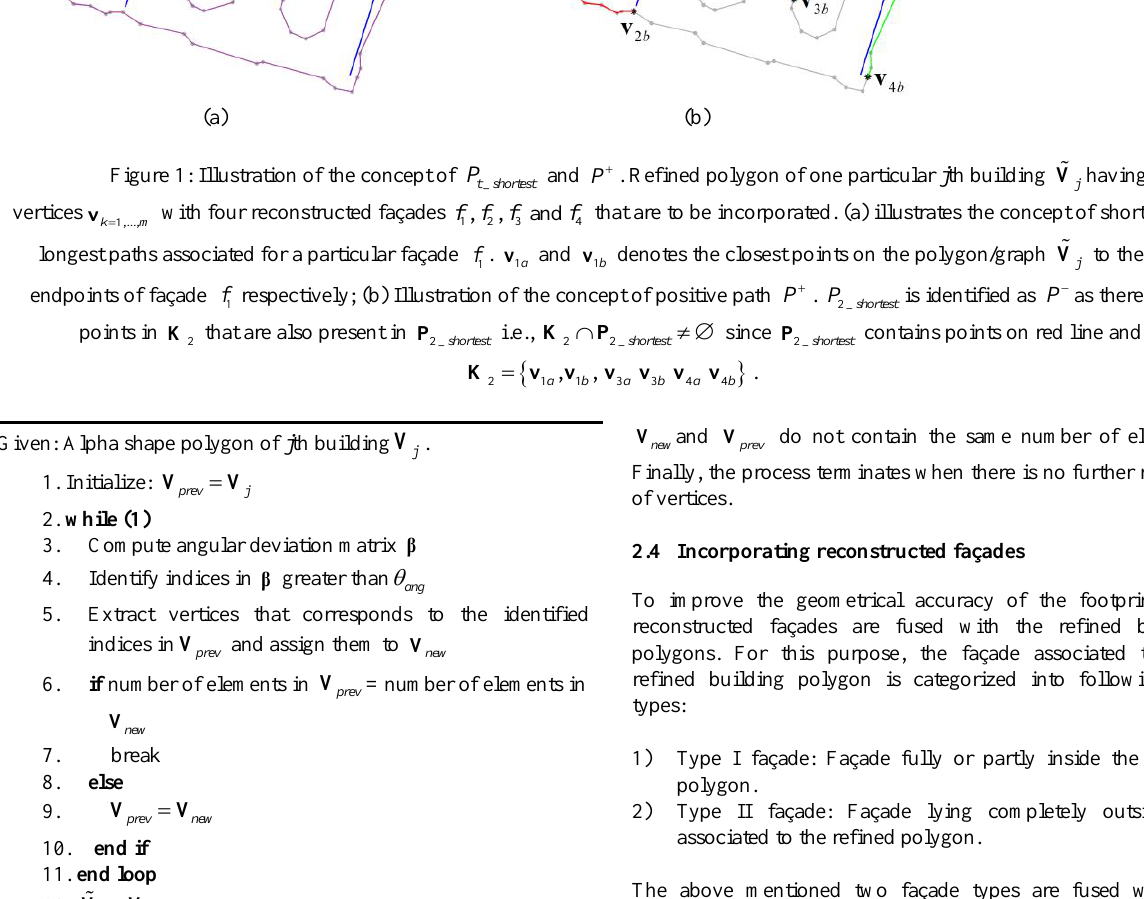
Table 1: Refinement of alpha shape